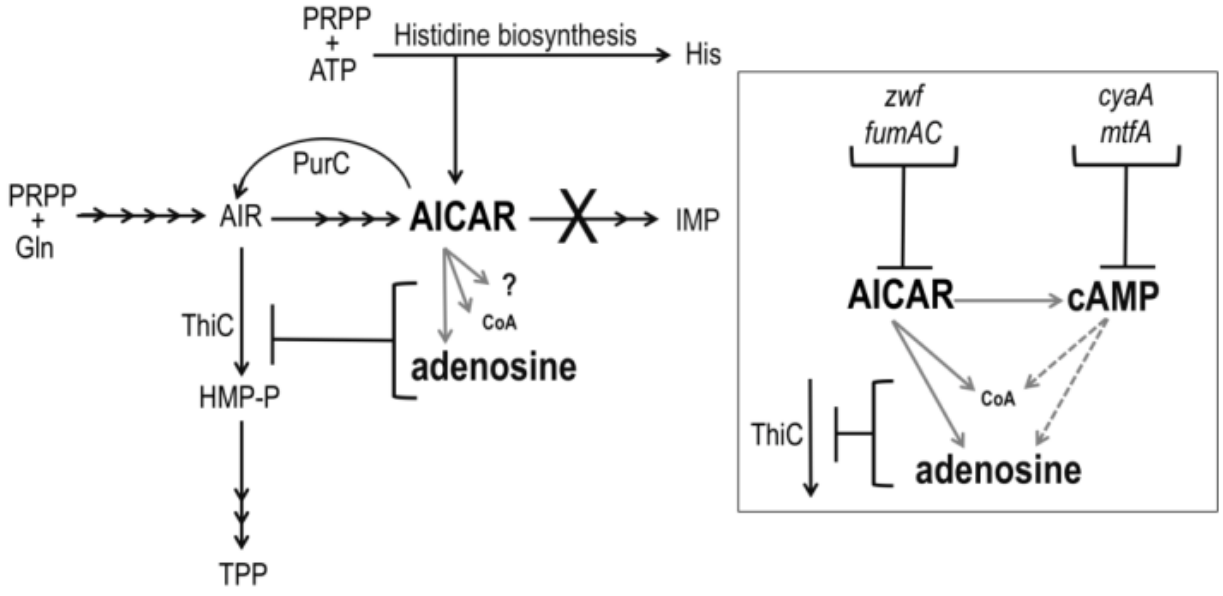
FIGURE 1: The role of AICAR in the purine histidine thiamine (PHT) metabolic network of S. enterica . Solid black arrows represent biochemi- cal reactions; corresponding gene products are beside the reaction they catalyze. AICAR-mediated points of metabolic crosstalk that impact thiamine synthesis (ThiC activity) are indicated with gray arrows. Inset: AICAR accumulation leads to elevated cAMP. Elevated AICAR and cAMP independently decrease pantothenate (CoA) pools and increase adenosine pools demonstrating that these pools are subject to direct (solid lines) and indirect (dashed lines) effects of AICAR accumulation. These altered pools potentially contribute to decreased ThiC activity; loss of function mutations ( zwf , fumAC , cyaA , mtfA ) modulated AICAR and/or cAMP levels and restored thiamine